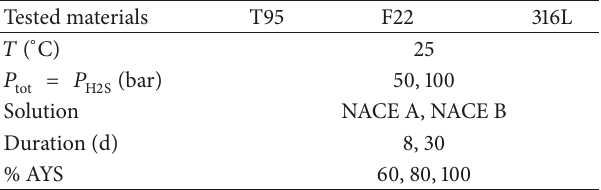
Table 3: Operating conditions in “medium pressure